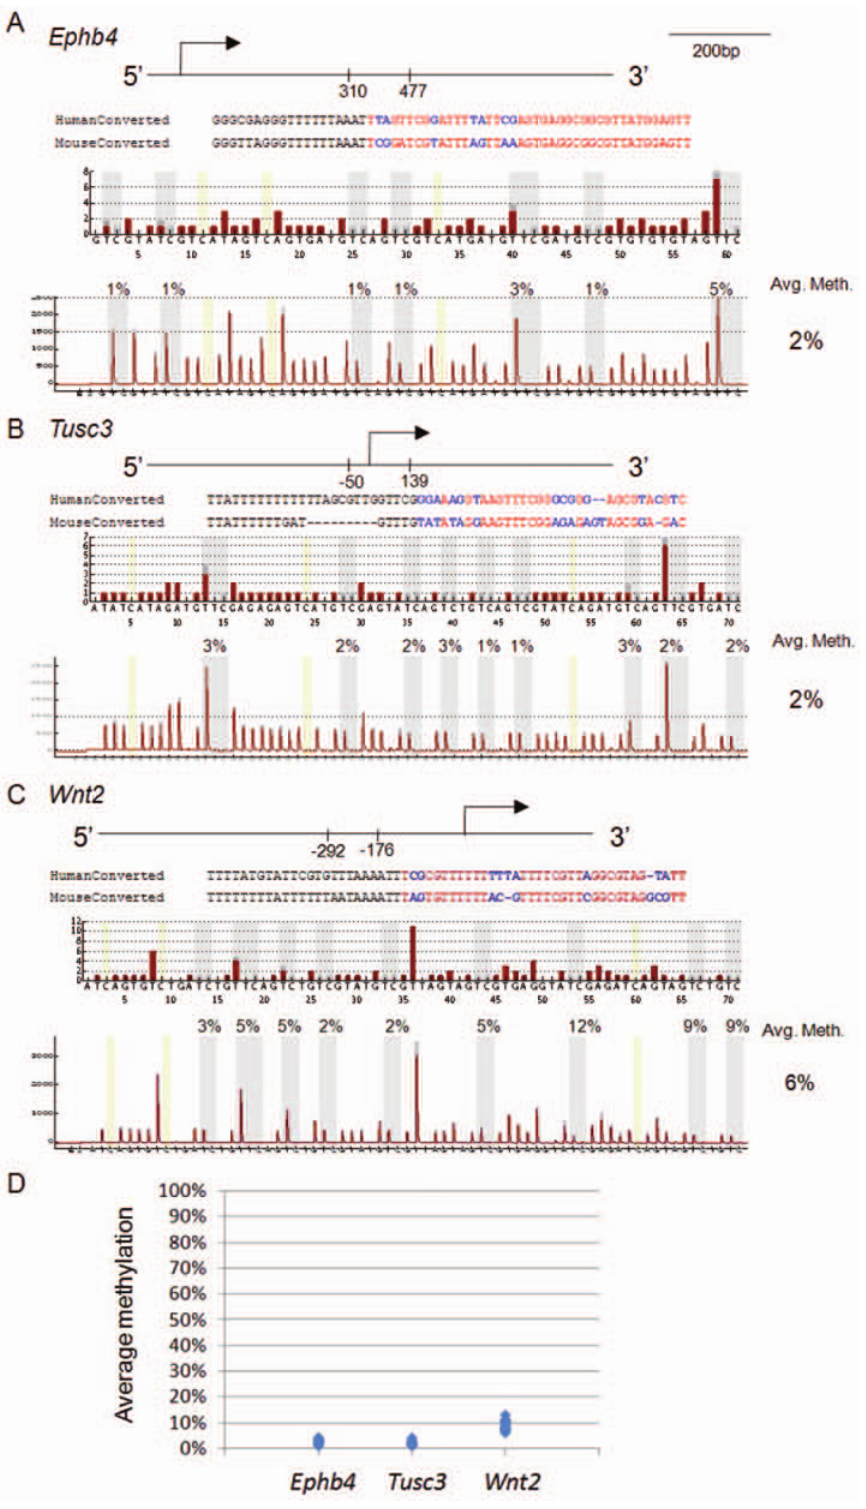
Figure 5. DNA methylation status of MAP conserved regions in mouse. Schematic of (A) Ephb4 locus (310 to 477 relative to the transcriptional start site according to NM_010144), (B) Tusc3 locus ( 2 50 to 139 relative to the transcriptional start site according to NM_030254) and (C) Wnt2 locus ( 2 292 to 2 176 relative to the transcriptional start site according to NM_003391), showing the regions investigated by bisulfite pyrosequencing. Sequence alignments on bisulfite converted DNA between human and mouse at the first 60 nucleotides including the sequencing primers are shown. Sequences highlighted in red are the nucleotides being investigated while the nucleotides highlighted in blue are the differences between them. Reference pyrograms are provided and one representative sample for each locus is shown. (D) Summary of methylation level at Ephb4 , Tusc3 and Wnt2 in 21 outbred mice. No ‘‘on-or-off’’ methylation variation is found in the mouse conserved regions.